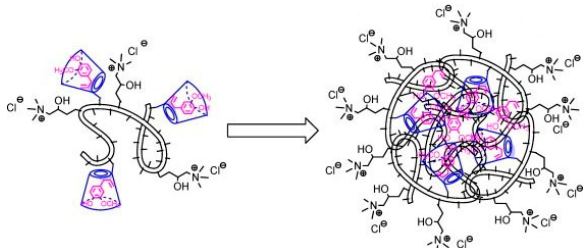
Figure 15. Schematic structure of inclusion complex between eugenol (pink) and quaternized chitosan (black) grafted with β -cyclodextrin (blue) forming self-aggregated micellar structures. Reprinted from reference [168], Copyright 2012, with permission from Elsevier.